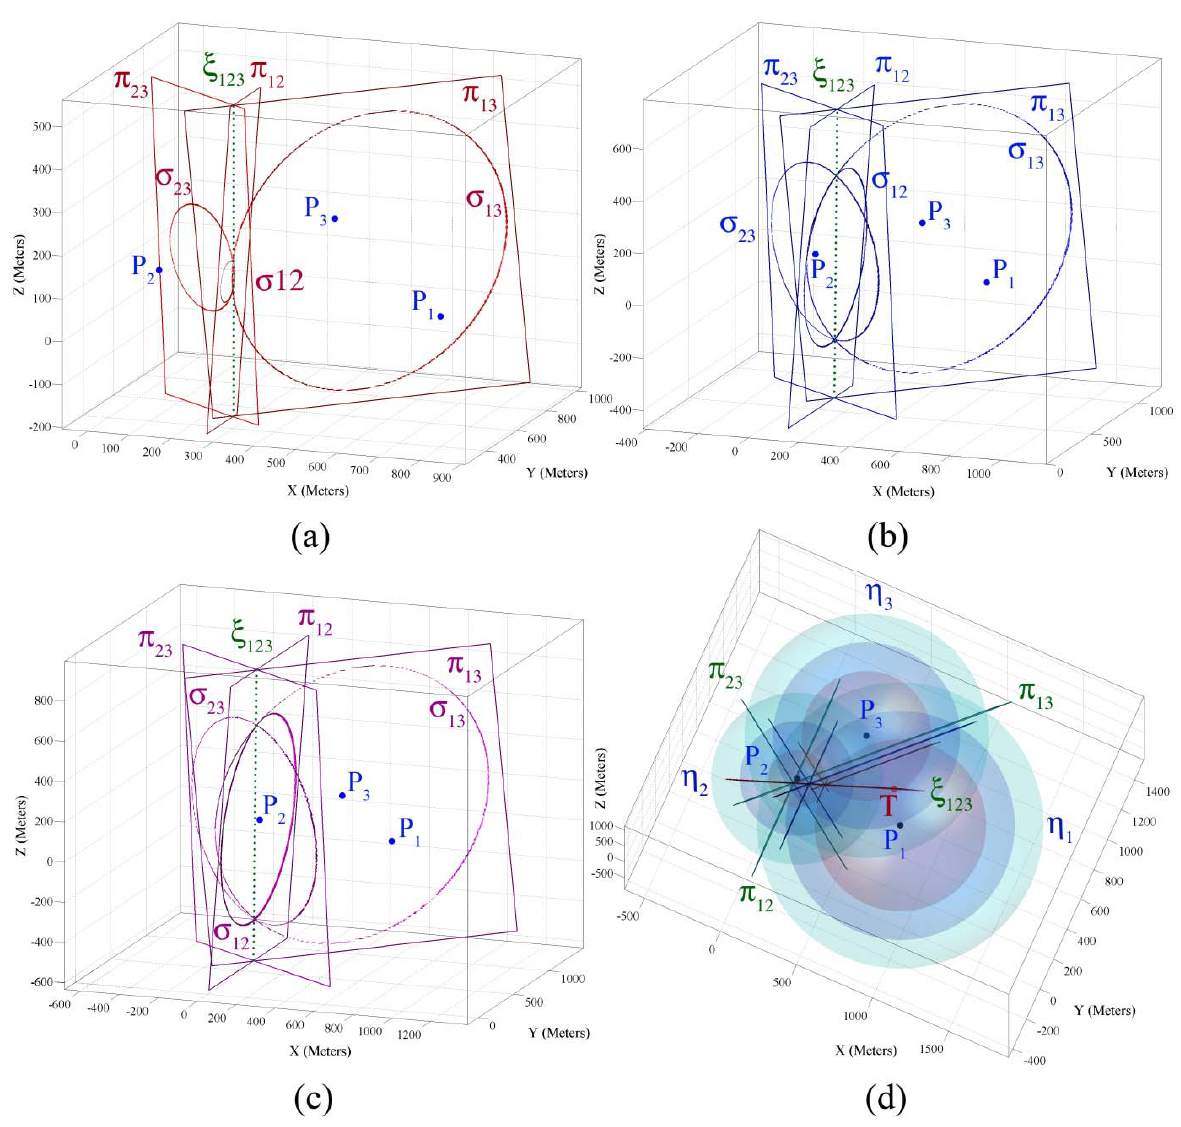
Figure 5. The intersection surfaces, the pencil and the axis plane of three sensing hypercones (a). At time t = +1.5, (b). At time t = +2.0, and (c). At time t = + 2.5, (d). The axis plane of the pencil passes through point that representing real target object’s spatio- temporal